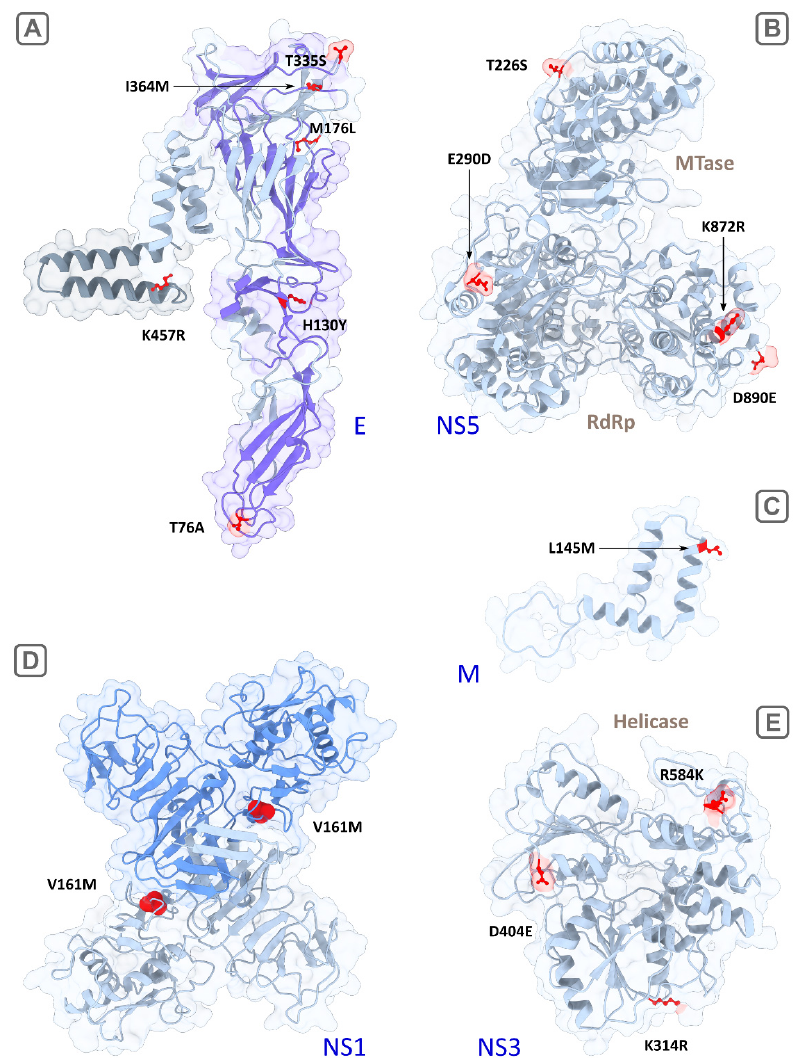
Figure 4. Visualization of reconstructed 3D structures of TBEV proteins, with the strain SofjinKSY used as a template (AEP25267.2). The suggested determinants of encephalitic and hemorrhagic